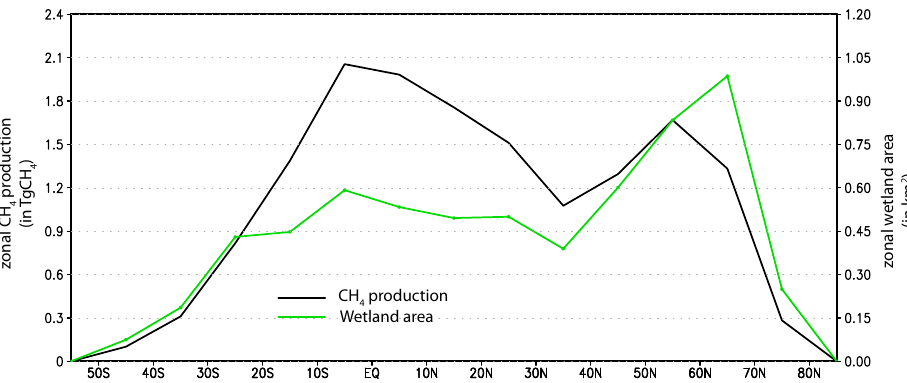
Fig. 1. TRENCH simulated PIH wetlands during June, the month of maximum wetland extent (green line), and CH 4 emissions (black line), both integrated zonally and by 10 ◦ latitude